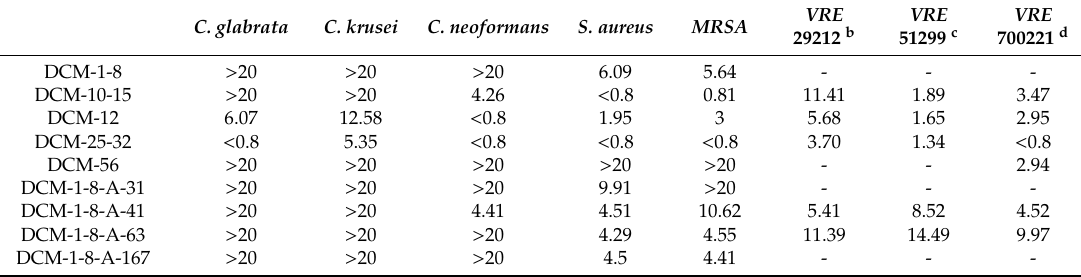
Table 2. Antimicrobial activity (IC 50 in µ g / mL) of Machaerium DCM fractions a